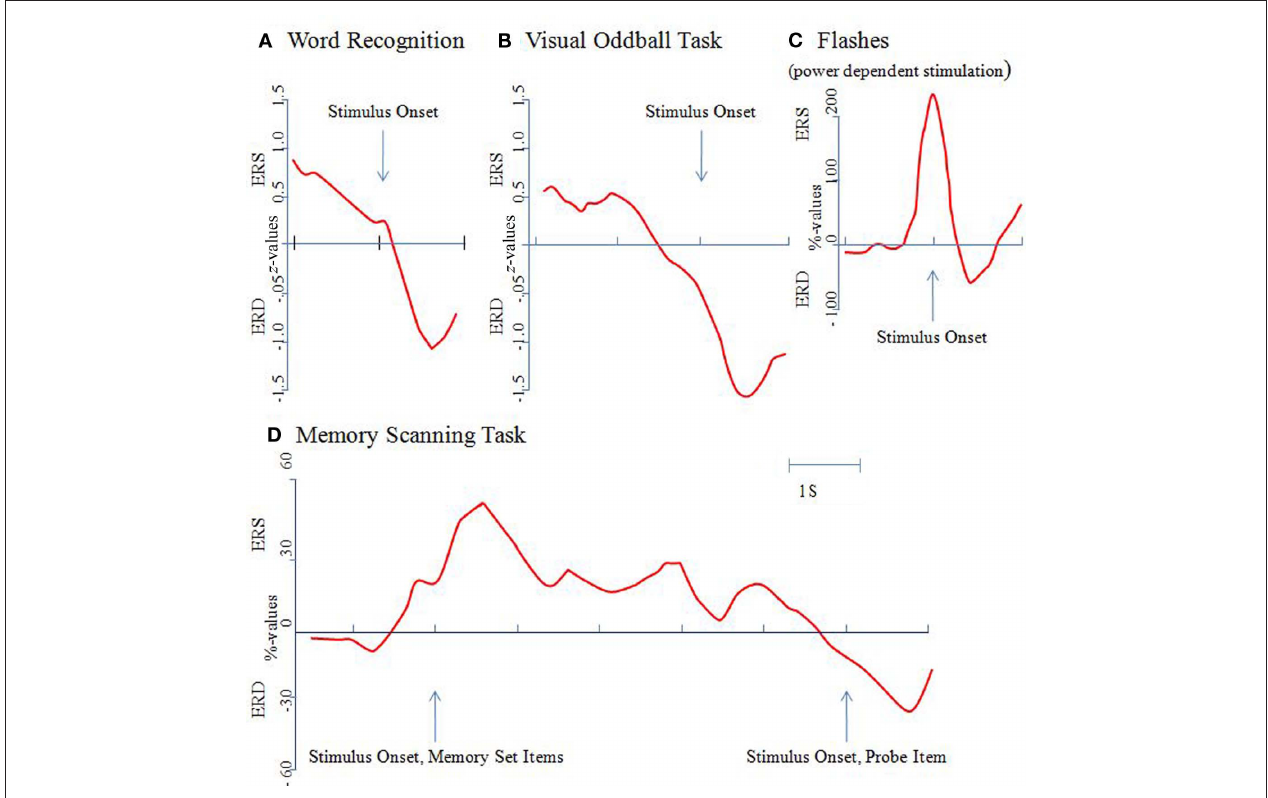
Figure 1 | The event-related alpha power response is task, not stimulus dependent. Alpha power changes were determined relative to a pre-stimulus reference interval and were calculated as percentage or z -values. An increase in power is termed event-related synchronization (ERS), a decrease event-related desynchronization (ERD). All of the results shown here are for the upper alpha band (10–12 Hz) and from posterior recording sites [with the exception of the data shown (D) which were recorded from temporal sites]. (A) In a word recognition task, a brief and transient increase in power can be observed in response to the onset of a correctly recognized word. Then, a large ERD develops, reaching a